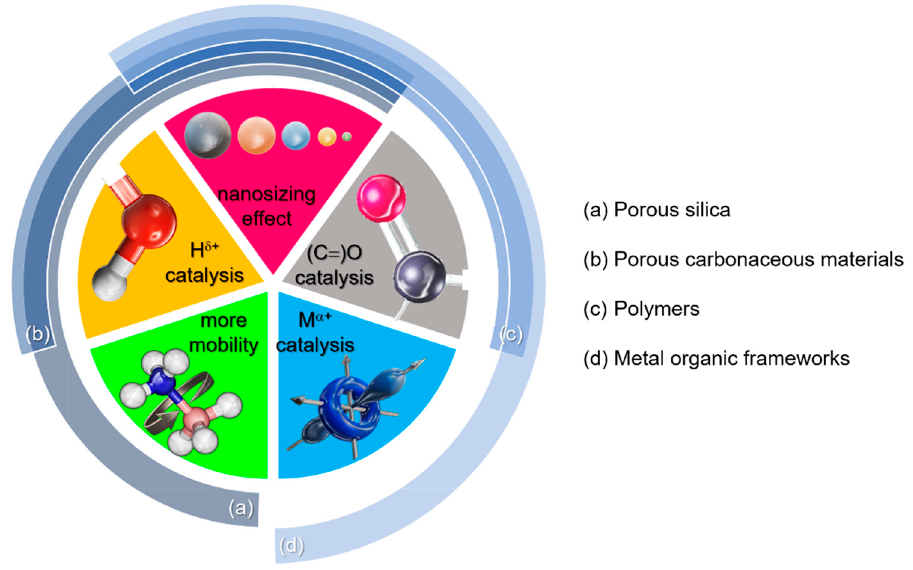
Figure 15. Ammonia borane nanoconfinement into scaffolds: the destabilization effects.